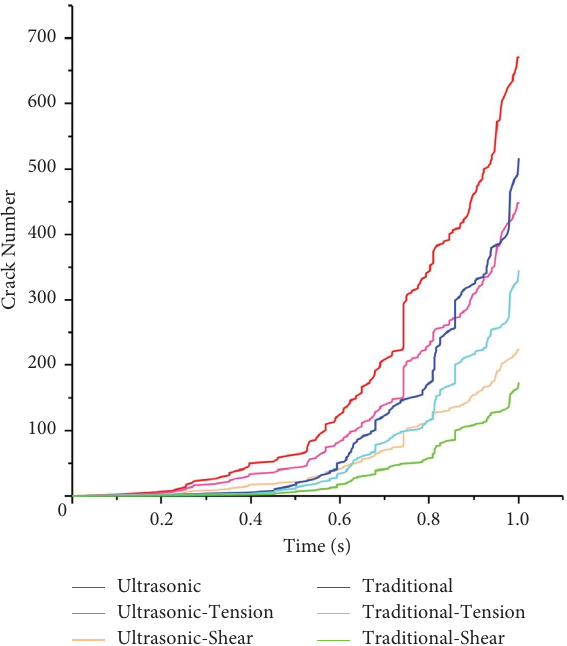
Figure 9: Crack number variation curve with